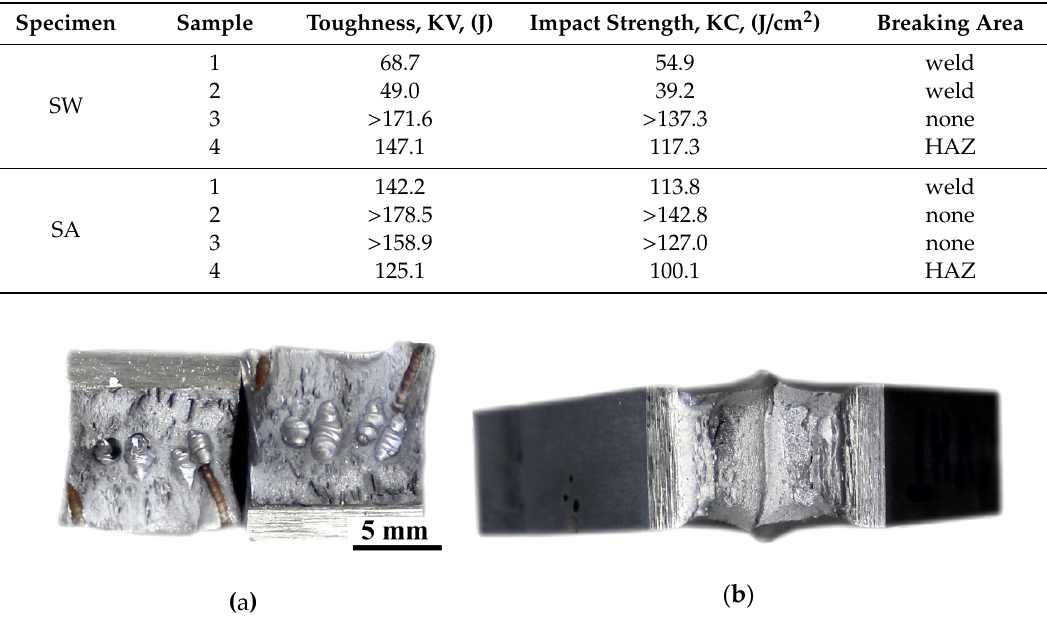
Figure 13. Cross- sections of samples after the Charpy impact test: ( a ) Sample 1, specimen SW, Figure 13. Cross-sections of samples after the Charpy impact test: ( a ) Sample 1, specimen SW, broken in the broken in the weld; and ( b ) Sample 3, specimen SA. weld; and ( b ) Sample 3, specimen